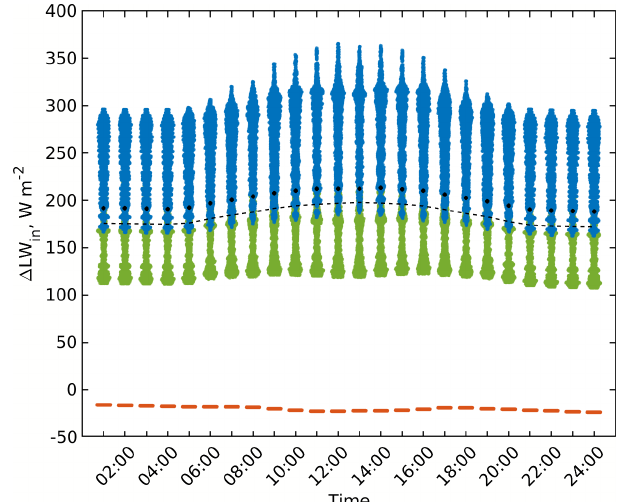
Figure 9. Changes in the received LW irradiance within the focus domain of the simple urban configuration when considering sur- face thermal emissions (RTM_04) compared to the RTM_03. Vio- lin, mean, and median colours are used in the same way as those in Fig.